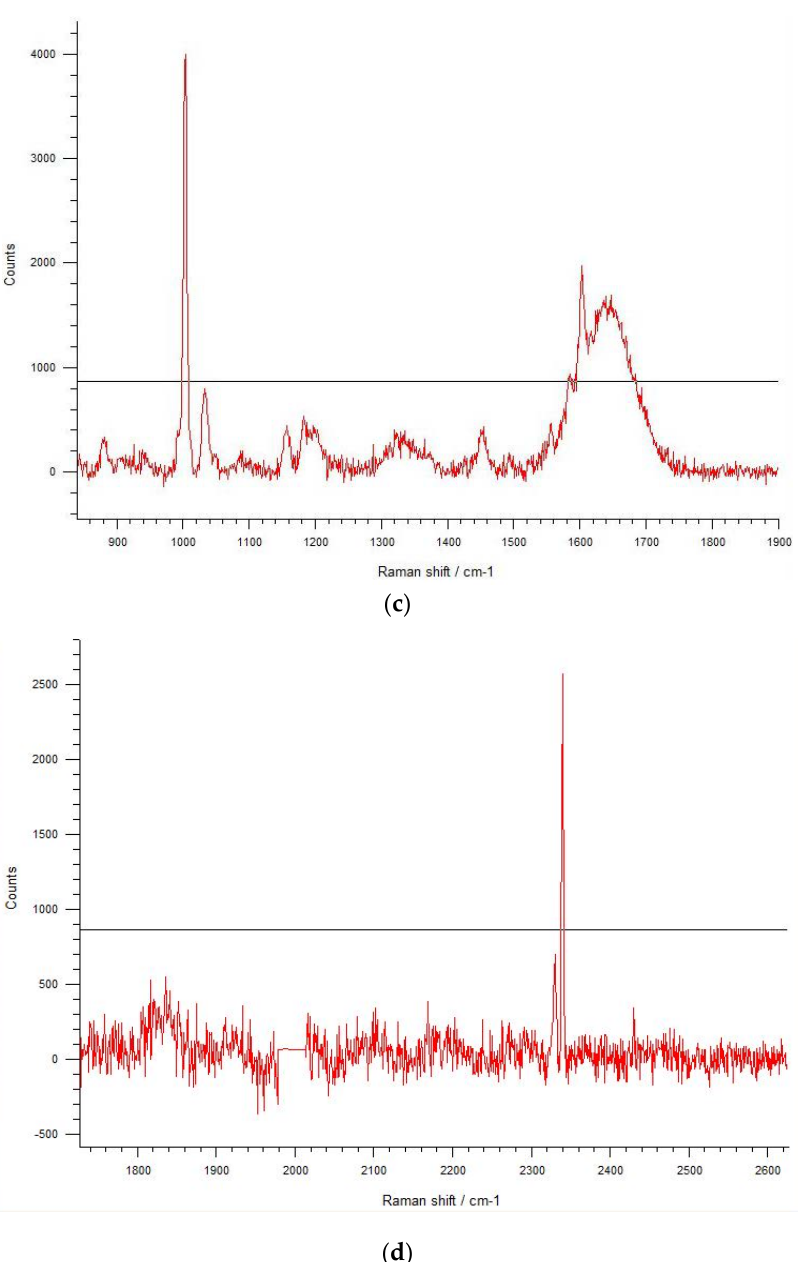
Figure 9. Surface-Enhanced Raman Spectroscopy (SERS) analysis of the four samples. From left to right: ( a ) TCA-AgNP; ( b ) TCA-AgNP-PI; ( c ) Cinn-AgNP; ( d ) Cinn-AgNP-PI.